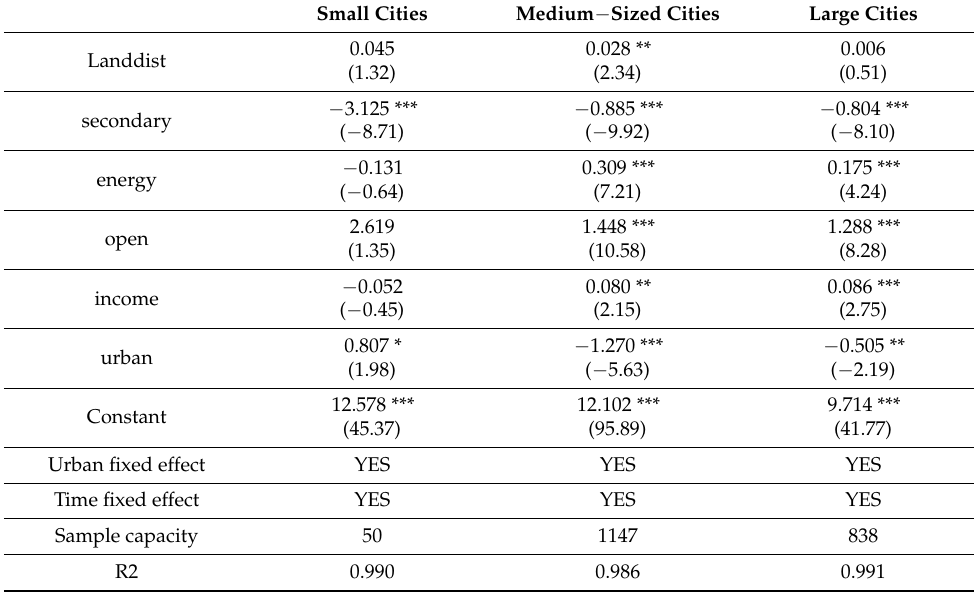
Table 5. Estimation results from sub-city size